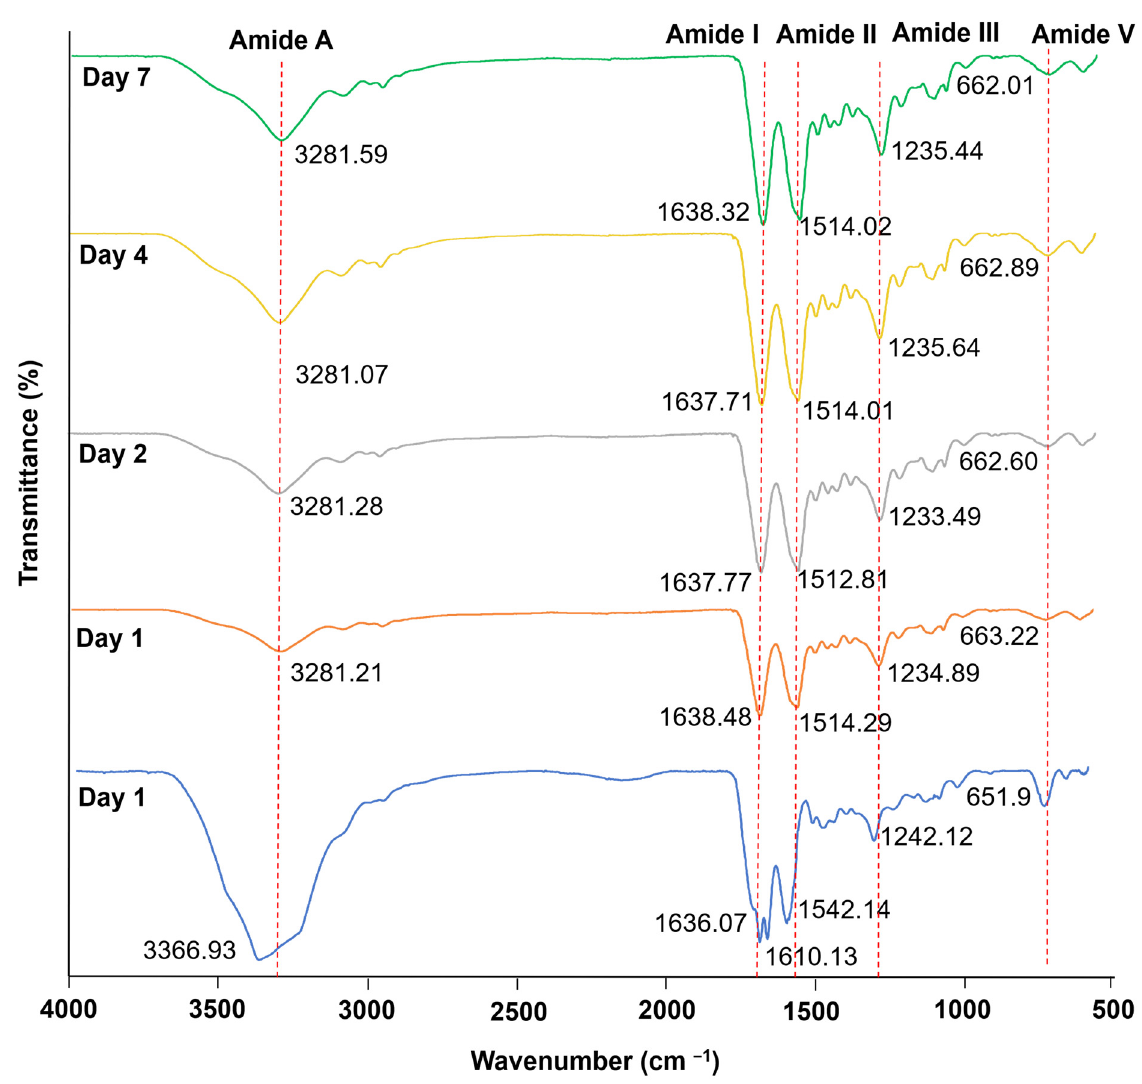
Figure 3. FT-IR Spectroscopic analysis of modified silk fibroin with glycidyl methacrylate on various dialysis periods. The FTIR spectra shows the presence of Amide I, II, III, and V bending at 1638 cm − 1 , 1514 cm − 1 , 1234 cm − 1 , and 662 cm − 1 peaks, respectively, in a β − sheet structure. N-H stretching of amide A groups (about 3300 cm − 1 ) overlapped with O − H absorption. Blue line, dialysis day 0; orange line, dialysis day 1; grey line, dialysis day 2; yellow line, dialysis day 4; and green line, dialysis day 7. FT-IR, Fourier transform Infrared.